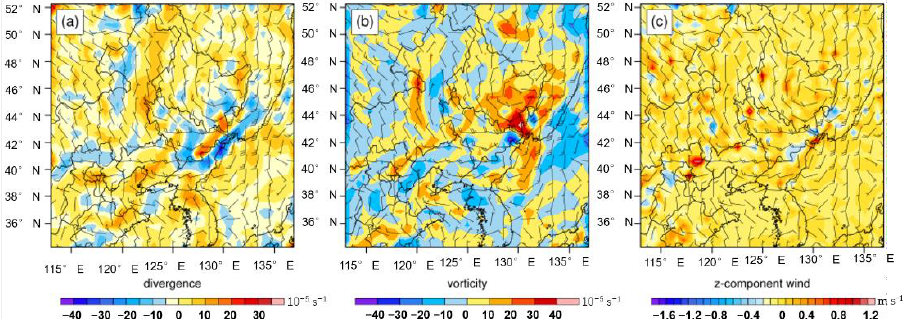
11 of 16 Figure 9. Vertical wind shear between 1000 and 3000 m (m s −1 ) at ( a ) 08:00 LST; ( b ) 17:00 LST in Domain 2 on 3 July 2019. Figure 10a shows that at 17:00 LST, in the 850 hPa divergence field, in the southeast of the cold vortex, a NE – SW-oriented convergence zone appeared from eastern Hei- longjiang to eastern Jilin, and a divergence zone was close to it in the southeast. There was a NE – SW-oriented convergence zone in central Liaoning. There was a divergence zone with a −15 × 10 −5 s −1 minimum core between the two convergence zones. They coupled with each other well. The satellite pictures (Figure 3) show that the north side of the squall line was very smooth, which was perhaps related to the dry and cold air intruded from